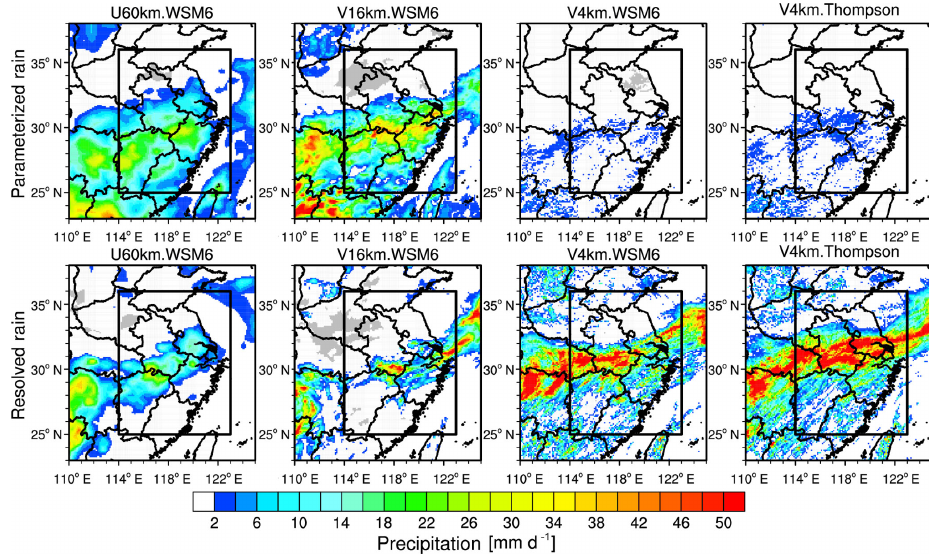
Figure 5. Spatial distribution of averaged parameterized and resolved precipitation during the event over East China from the simulations with resolutions of 60, 16, and 4km.